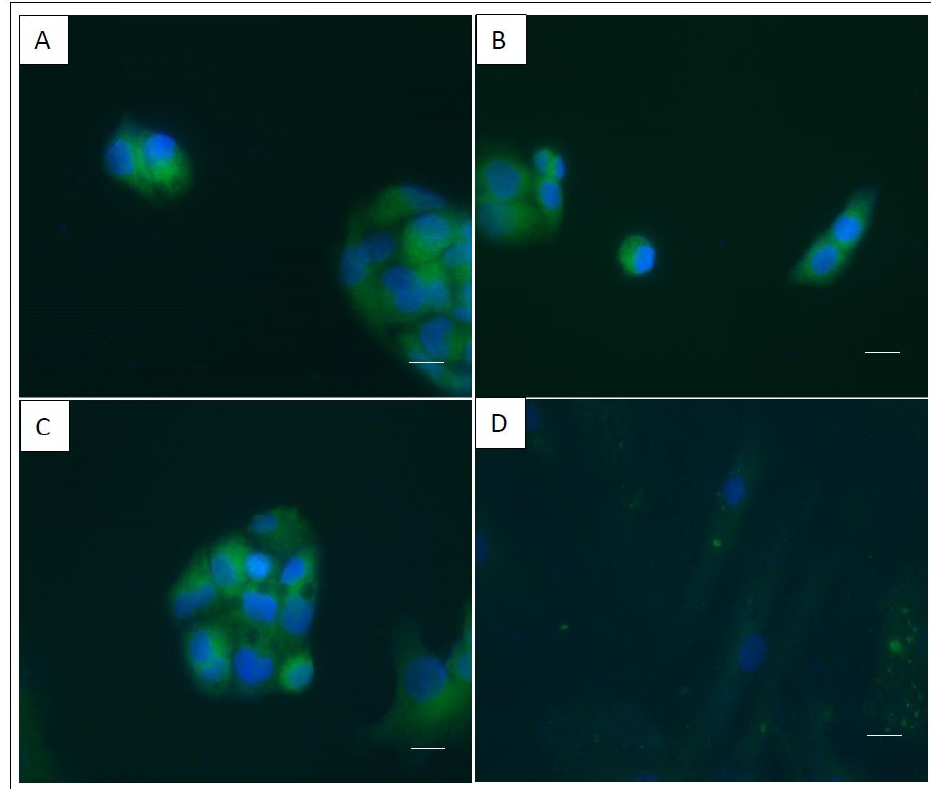
Figure 4. Coagulation factor V immuno-staining of cell lines. ( A ) WT HepG2. ( B ) KO HepG2. ( C ) TT HepG2. ( D ) hASCs as negative control (scale bar, 50 μ m). Representative images from three different experiments.